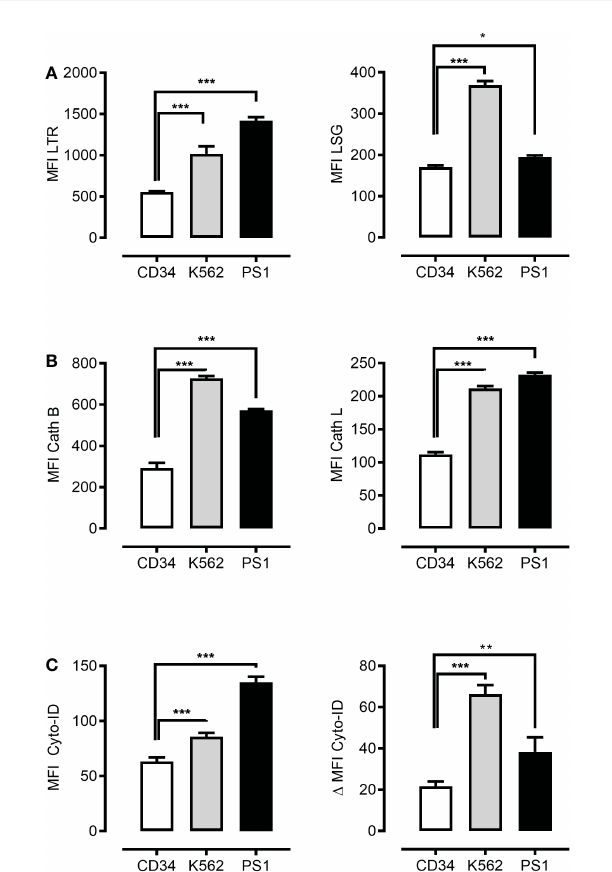
FIGURE 1 Leukemia cells present higher autophagosomal and lysosomal compartments. Flow cytometric analysis of lysosomal mass using LysoTracker Red (LTR) (A) left panel , lysosomal acidity using LysoSensor Green (LSG) (A) right panel , cathepsin B using cathepsin B and cathepsin L staining dye respectively (Cath B) (B) left panel and cathepsin L (Cath L) (B) right panel , autophagosomal compartment using Cyto-ID dye (C) left panel and autophagic fl ux (C) right panel in CD34 + cells, K562 cell line and patient-derived leukemic blast (PS1). Data are presented as mean ± S.D. and are representative for experiments with two to three replicates. *p < 0.05, **p < 0.01, ***p < 0.001 by One-way ANOVA with Dunnett ’ s multiple comparison test. *P < 0.05; **P < 0.01; ***P <